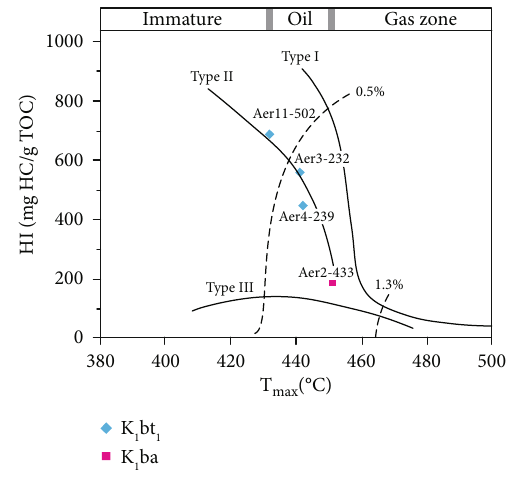
Figure 2: HI versus T max values of mudstone samples from the Aer